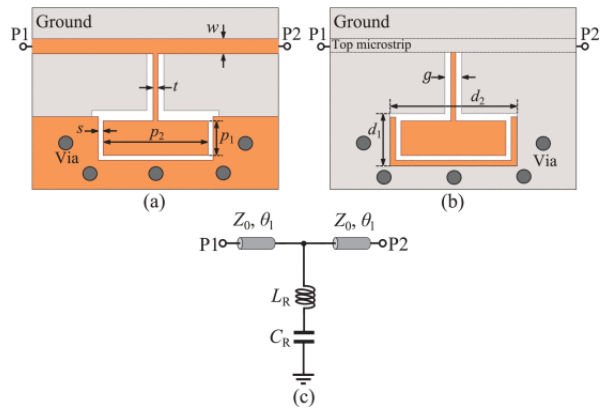
Figure 7. Topology of the SISS-based frequency variation sensor reported in [46], including the top ( a ) and bottom ( b ) views, and lumped element equivalent circuit model ( c ). From [46], reprinted with permission.